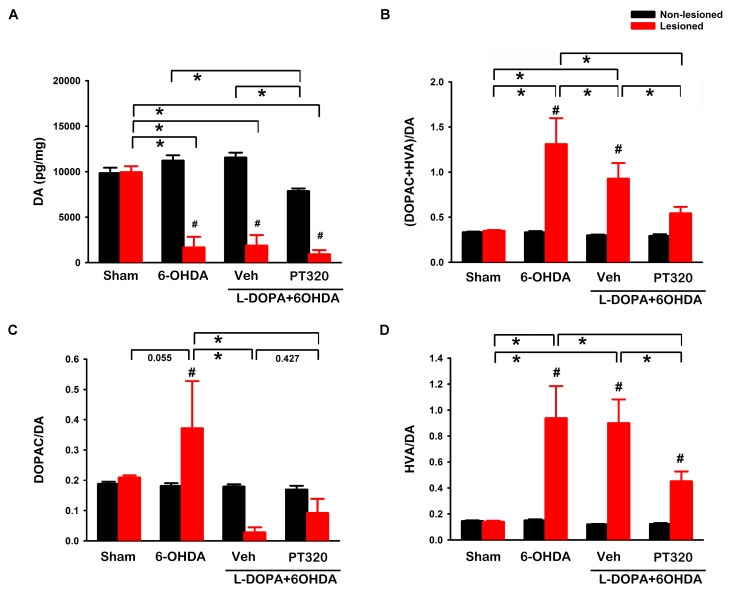
Dopamine (DA) and DA turnover in the striatum. (A) 6-OHDA lesioning significantly reduced DA levels (*p < 0.001) in the lesioned striatum (red bars). L-DOPA/benserazide or L-DOPA/benserazide + PT320 treatment did not alter DA after lesioning (p = 0.844, 6-OHDA vs. L-DOPA/benserazide + 6-OHDA; p = 0.491, 6-OHDA vs. L-DOPA/benserazide + PT320 + 6-OHDA). (B) DA turnover was examined by comparing DA metabolite levels (DOPAC + HVA) with DA. DA turnover was enhanced by the 6-OHDA lesion (*p < 0.001, sham vs. 6-OHDA). PT320 significantly reduced DA turnover in the lesioned striatum (*p = 0.028, 6-OHDA + L-DOPA/benserazide vs. 6-OHDA + L-DOPA/benserazide + PT320). 6-OHDA lesioning significantly increased (C) DOPAC/DA (#p = 0.019, lesioned vs. non-lesioned striatum) and (D) HVA/DA ratio (#p < 0.001, lesioned vs. non-lesioned striatum; *p < 0.001, sham vs. 6-OHDA). HVA/DA ratio was significantly reduced by PT320 in the lesioned animals receiving L-DOPA (*p = 0.006, 6-OHDA + L-DOPA/benserazide vs. 6-OHDA + L-DOPA/benserazide + PT320). #Significant difference between the lesioned and non-lesioned side striatum; *significant difference among groups. Two-way ANOVA + post hoc Newman–Keuls test.